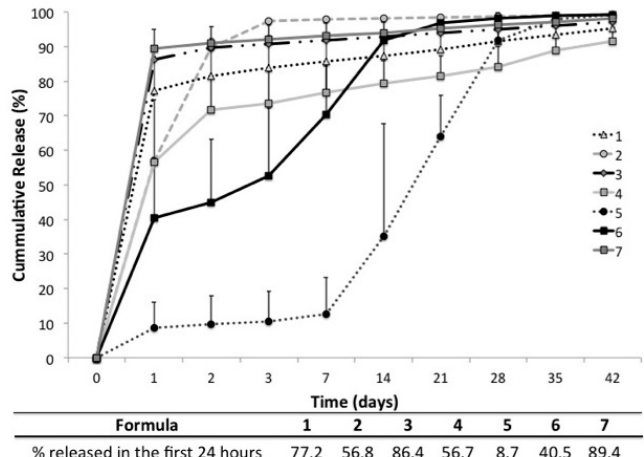
Figure 5. Vancomycin release kinetics for each formulation are shown in the line graph. One of the major distinctions in the formulations is the percent of drug released in the first 24 h. Note that formulation 2 was a larger sphere while all other formulations are smaller cylindrical disks. Standard error mean are shown for each formulation.